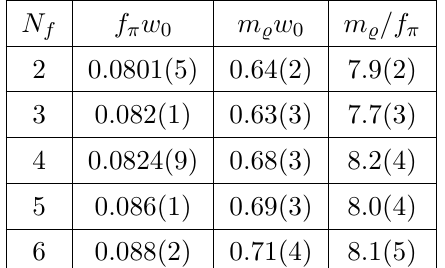
Figure 4 . Our (cid:12)nal results for the ratio m % =f (cid:25) in the chiral-continuum limit for each N f . Two procedures are used for the chiral-continuum extrapolation in order to assess systematic errors; the two agrees within errors. Method one is our (cid:12)nal result and method two serves as a cross-check or con(cid:12)rmation.